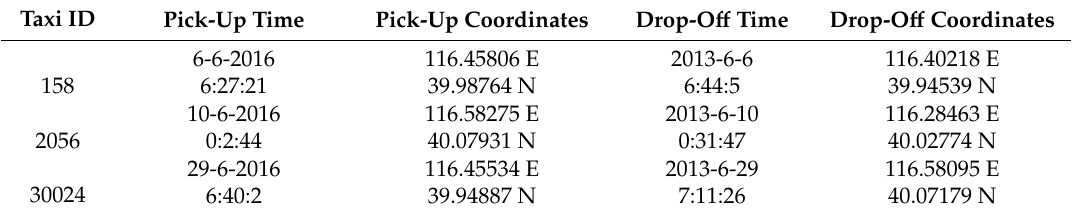
Table 2. Business data from Dianping.com.